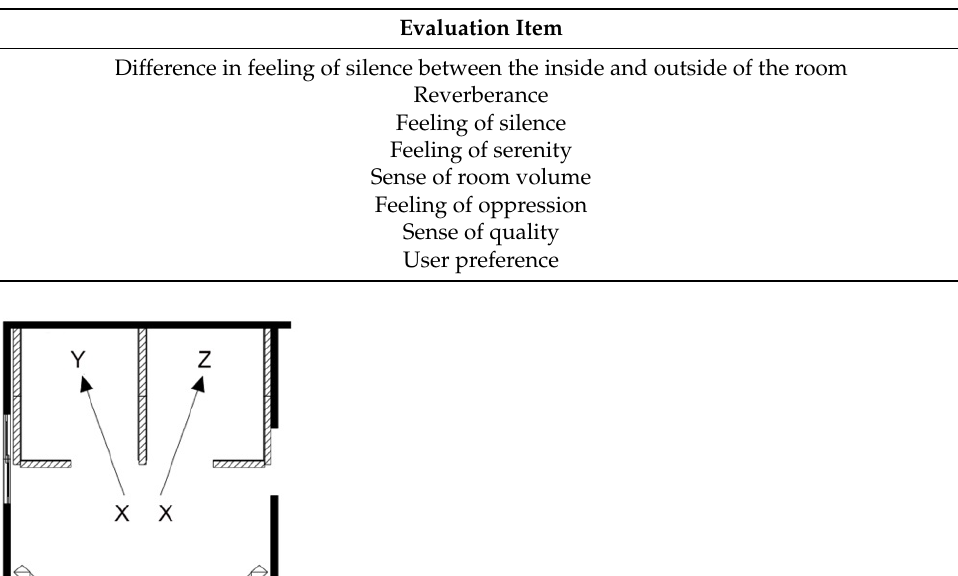
Table 2. Evaluation items for the paired comparison experiment.